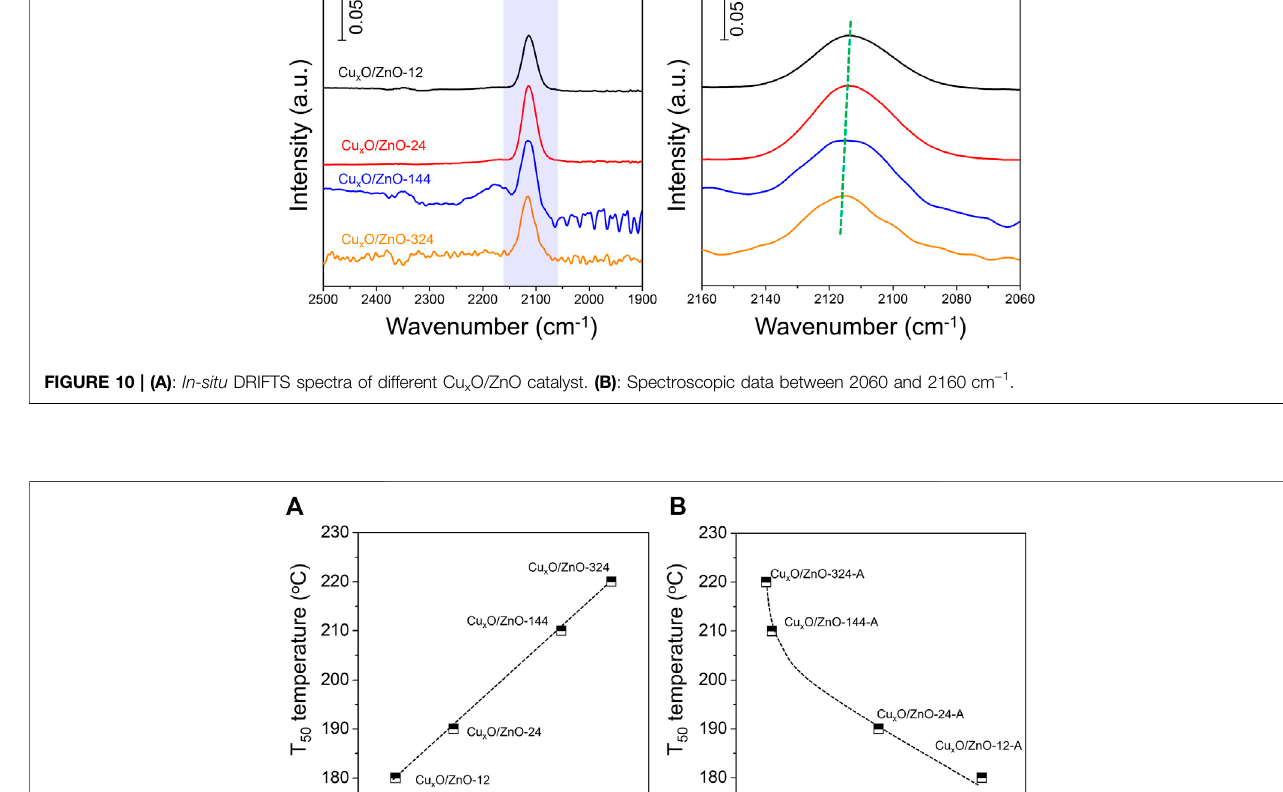
(B) dependence of the T 50 temperature and relative O ad